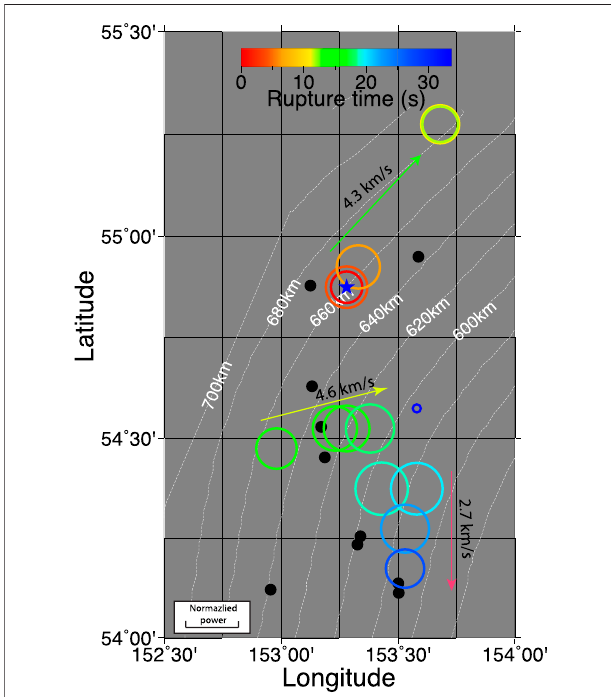
FIGURE 4 | The fi nal back-projection rupture model. The colored circles indicate the subevents. Their areas are proportional to the normalized power, which is indicated by the scale bar. The color bar represents the rupture times of the subevents. The black dots depict the aftershocks, while the blue star indicates the hypocenter. The white dashed lines are depth contours of the subducting Paci fi c slab (Hayes et al., 2012). The arrows indicate the rupture